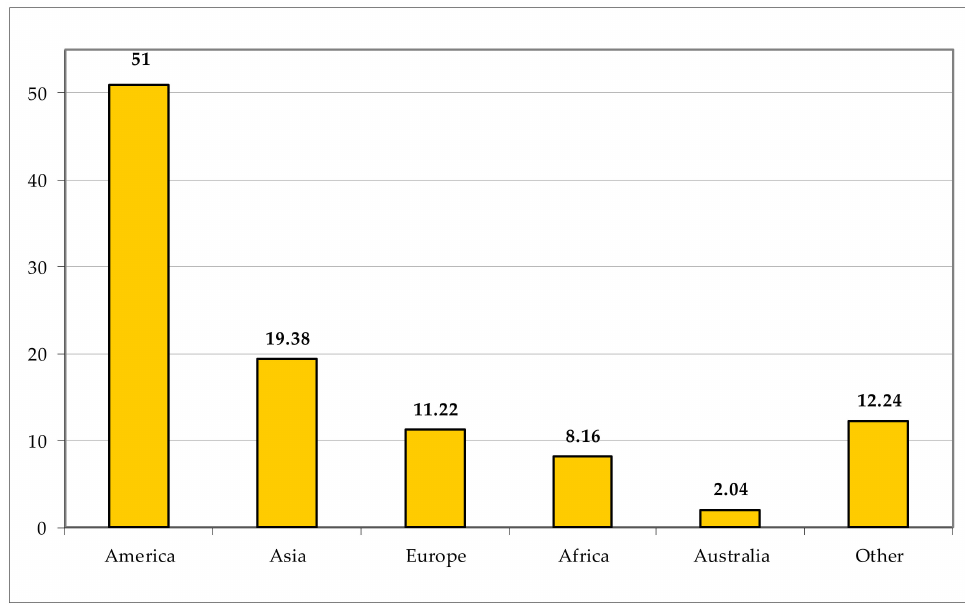
Figure 41. Share of aliens plant species and subspecies (percentages in axis y) by thier per origin.